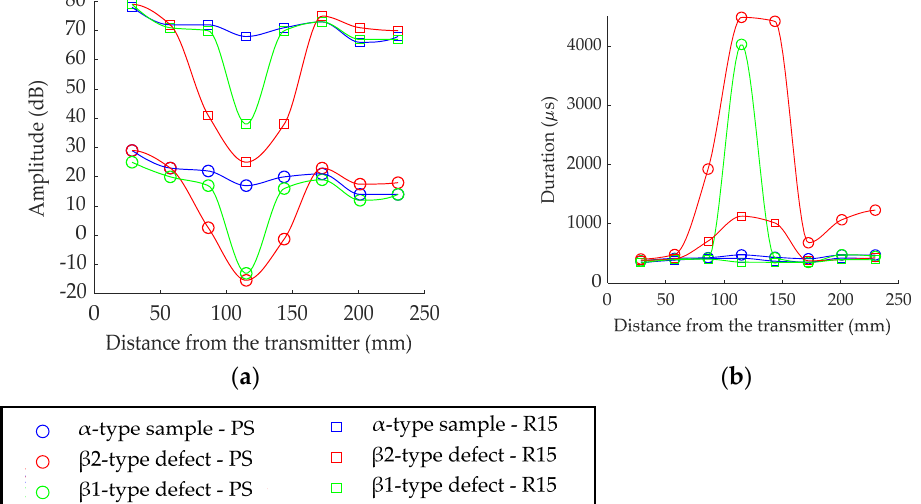
Figure 7. Variation of ( a ) amplitude and ( b ) duration as a function of the distance between the transmitter and the perfect sensor (PS, o) or the R15 sensor (□) for the various assemblies.